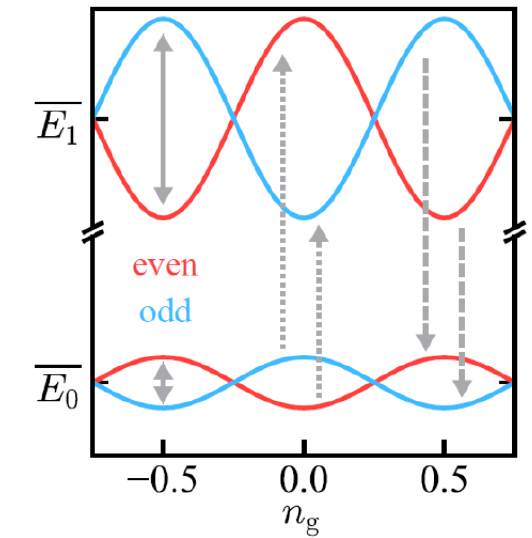
Figure 4: (adapted from Ref. [ 19 ] ) Two lowest energy levels of the transmon qubit. The “even” and “odd” labels mark states of opposite charge